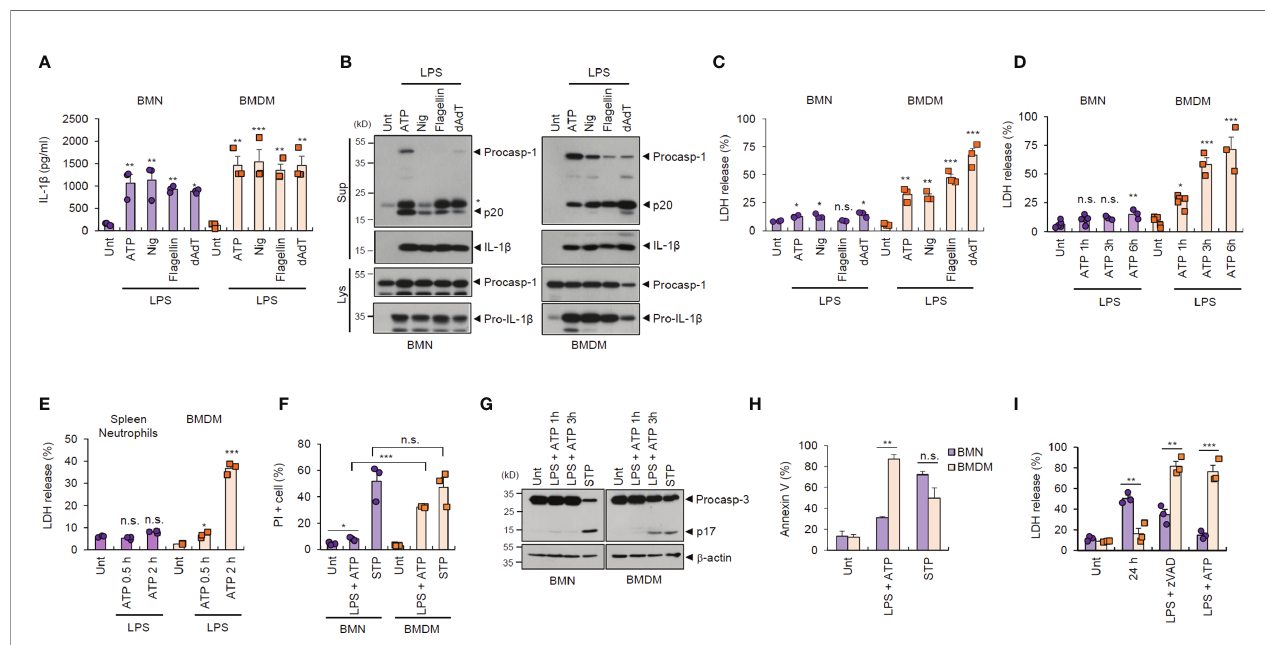
FIGURE 1 | Neutrophils resist in fl ammasome-dependent cell death. (A) Quanti fi cation of IL-1 b in the culture supernatants of mouse bone marrow-derived neutrophils (BMNs) or macrophages (BMDMs) untreated (Unt) or primed with LPS (0.25 m g/mL, 2.5 h), followed by ATP (2.5 mM, 1 h) or nigericin (Nig, 5 m M, 1 h) treatment, or fl agellin (500 m g/mL, 6 h) or poly dA:dT (1 m g/mL, 6 h) transfection ( n = 3). (B) Immunoblots of mouse BMNs or BMDMs treated as in (A) . Culture supernatants (Sup) or cell lysates (Lys) immunoblotted with the indicated antibodies. The asterisk indicates a nonspeci fi c band. (C, D) Quanti fi cation of LDH in the culture supernatants of mouse BMNs or BMDMs treated as in (A) (C, n = 3) or primed with LPS (0.25 m g/mL, 2.5 h) and treated with ATP (2.5 mM, 1, 3, 6 h) (D, n = 3-5). (E) Quanti fi cation of LDH in the culture supernatant of mouse splenic neutrophils or BMDMs primed with LPS, followed by ATP treatment (0.5 or 2 h). ( n = 3) (F) Quanti fi cation of PI-positive mouse BMNs or BMDMs primed with LPS, followed by ATP (2.5 mM, 1 h) or treated with staurosporine (STP, 2 m g/mL, 6 h), as determined by fl ow cytometric analysis after propidium iodide (PI) staining. ( n = 3). (G) Immunoblots of cell lysates from mouse BMNs or BMDMs primed with LPS followed by ATP (1 or 3 h), or staurosporine (STP, 2 m g/mL, 6 h) treatment. (H) Quanti fi cation of phosphatidylserine-positive mouse BMNs or BMDMs treated with LPS (0.25 m g/mL), followed by ATP (2 h) or staurosporine (STP, 5 h), as determined by fl ow cytometric analysis after Annexin V-FITC staining ( n = 2 or 3). (I) Quanti fi cation of LDH release into the culture supernatant of mouse BMNs or BMDMs incubated with culture medium (24 h), treated with LPS (0.25 m g/mL, 24 h) in the presence of zVAD (20 m M) or treated with LPS (0.25 m g/mL, 2.5 h) followed by ATP (2.5mM, 3 h) ( n = 3). Data are expressed as the mean ± SEM. * P < 0.05, ** P < 0.01, *** P < 0.001, n.s. not signi fi